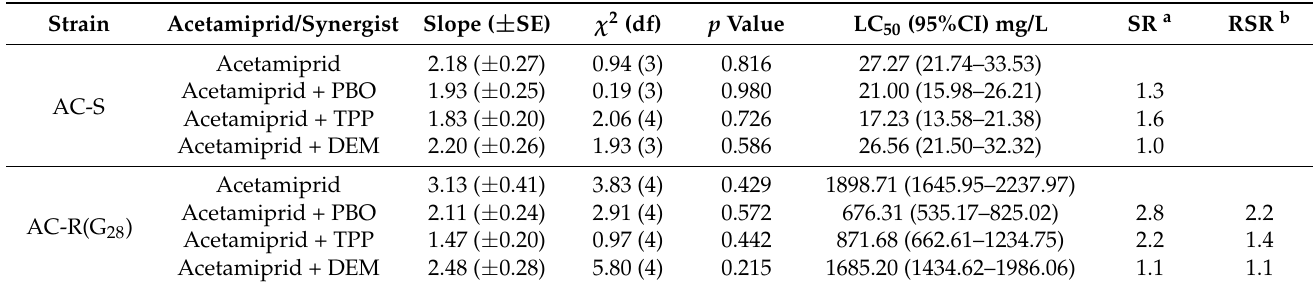
Table 3. Synergistic effects of PBO, TPP and DEM on the acetamiprid to the susceptible and acetamiprid-resistant strain of N. lugens.